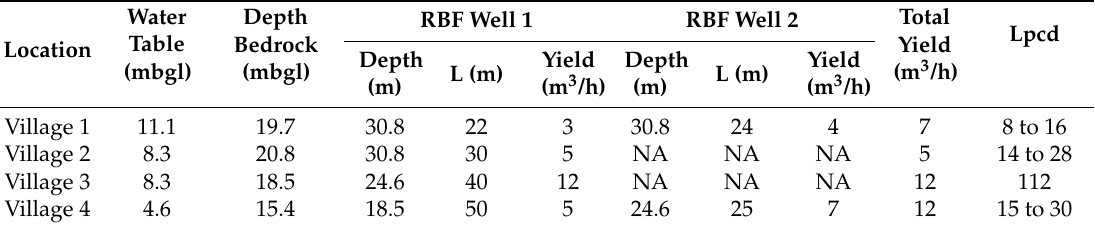
Table 1. RBF well